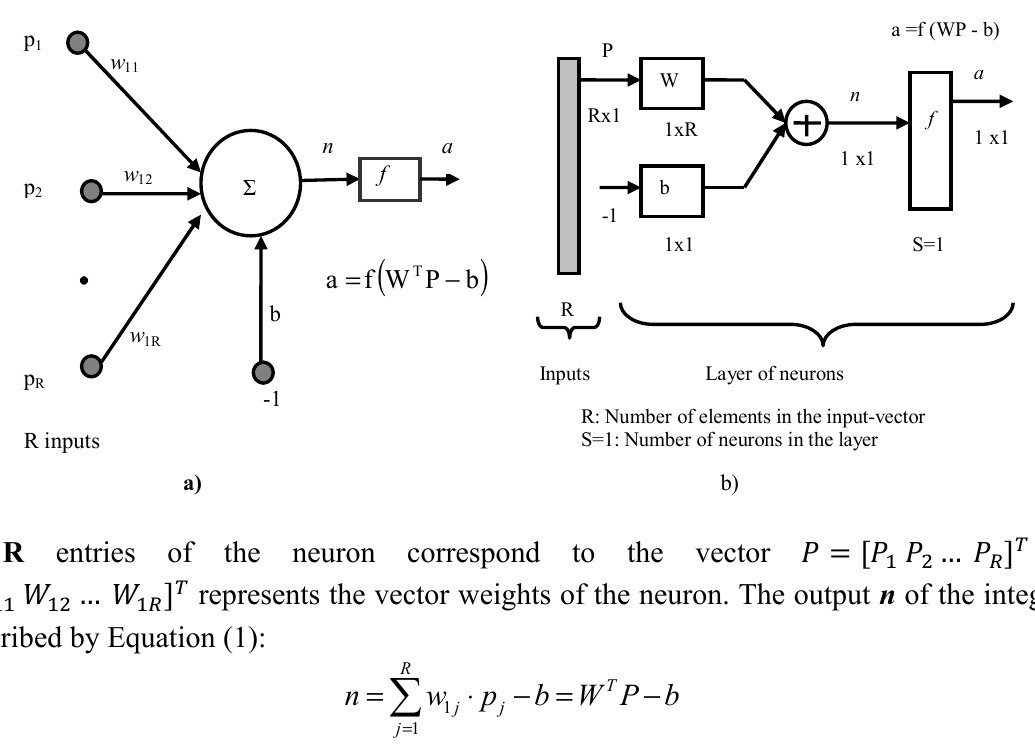
Figure 2. Representation of a neuron: ( a ) model; ( b ) matrix representation for S =